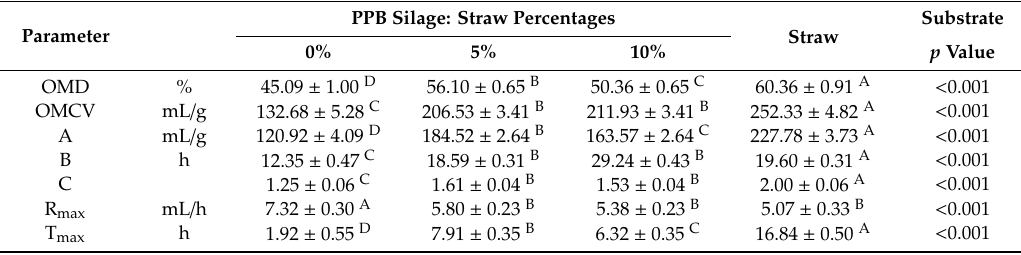
Table 2. Cumulative gas production, organic matter degradability and fermentation kinetics parameters of PPB silages and wheat straw.